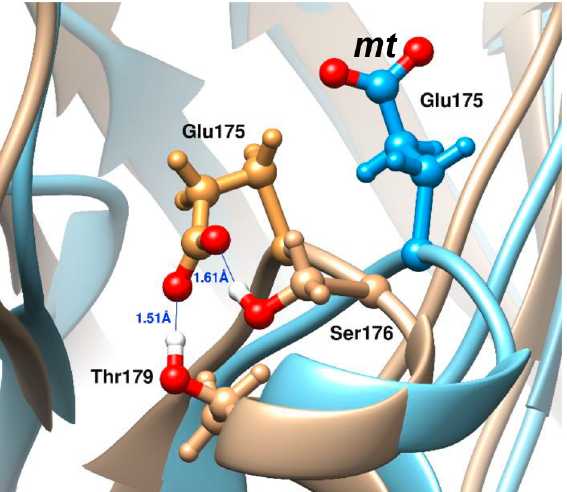
Figure 11. Two conformations of α Glu175 side chain in active site of bacterial luciferase. The superposition of luciferase structures taken from MD-simulations with no cosolvent (tan) and in presence 40% of sucrose (blue) is shown (the snapshots time is 30 ns). In water surrounding and in the presence of glycerol, α Glu175 can take a conformation stabilized by two strong H-bonds with α Thr179 and α Ser176 (side chains are shown as ball-and-sticks in tan color). In the presence of 20–40% of sucrose, the only conformation of α Glu175 side chain is one shown in blue color ( mt conformation according to [30]). In red the oxygen atoms are